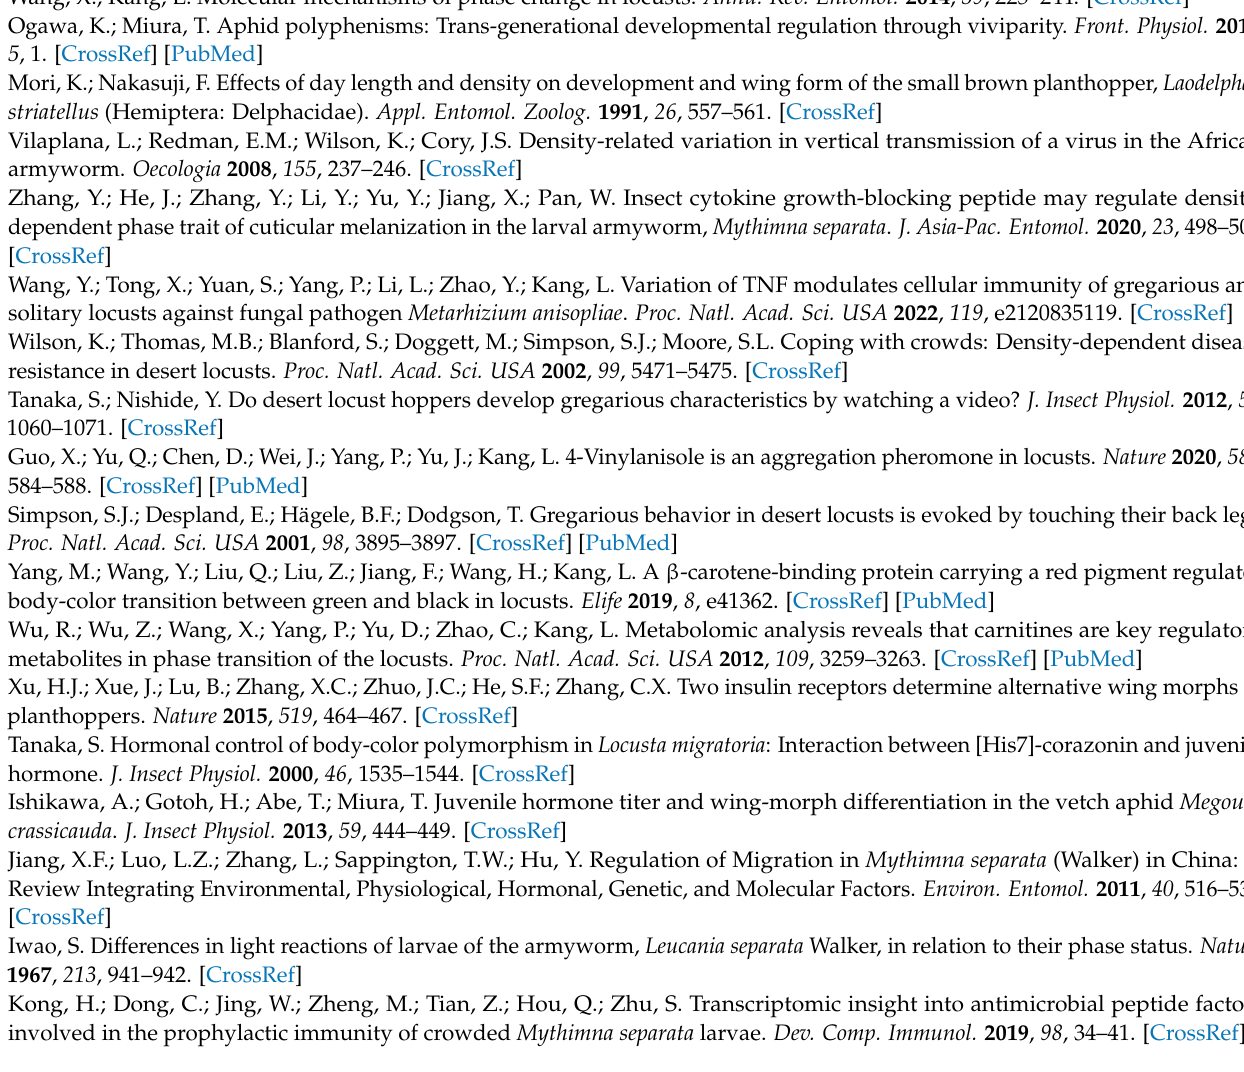
Table S4: List of all metabolites—POS; Table S5: List of all metabolites—NEG; Table S6: Supporting data for Figure 8a; Figure S1: Comparison of RNA-Seq and qPCR results; Figure S2: The quality rating results of the metabolomic experimental data; Figure S3: The chemical classification of